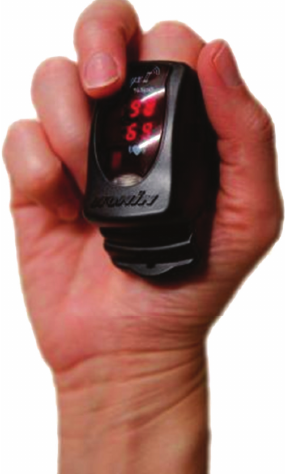
Figure 1: Application of the wireless Bluetooth pulse oximeter module (Onyx II 9560, Nonin Medical Inc., Plymouth,